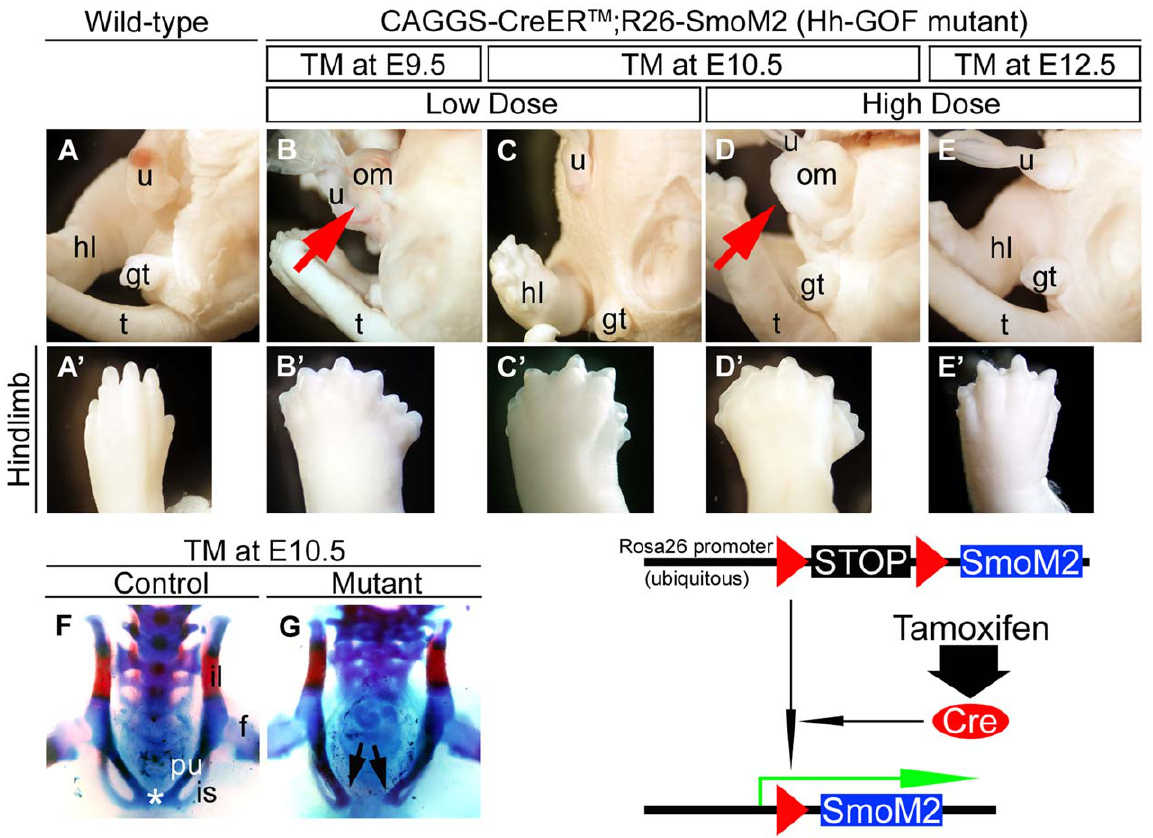
Figure 5. The conditional activation of Hh signaling by the protocols inducing omphalocele and pubic diastasis phenotypes. The R26-SmoM2 allele contains the constitutively activated form of Smoothened and a floxed stop cassette under the control of the Rosa26 promoter. By crossing R26-SmoM2 mice and the TM-inducible form of Cre-driver mice, administration of TM to the pregnant mice induced embryonic stage-specific gene recombination, allowing continuous activation of Hh signaling. The lateral view of the body trunk and the left hind limb of a wild-type embryo treated with a high dose of TM at E10.5 ( A , A’ ). Mutant embryos treated with a low dose of TM at E9.5 ( B , B’ ), a low dose of TM at E10.5 ( C , C’ ), a high dose of TM at E10.5 ( D , D’ ) and a high dose of TM at E12.5 ( E , E ’). Embryos were collected at E17.5 ( A–G and A’–E’ ). Mutant embryos treated with the low dose of TM at E9.5 and the high dose of TM at E10.5 showed omphalocele phenotypes ( B, D ; red arrows). Under such conditions, mutants displayed polydactyly phenotypes ( B’–E’ ). Control embryos at E17.5 developed a pubic symphysis ( F ; asterisk). Mutant embryos treated with a high dose of TM at E10.5 showed a pubic diastasis phenotype ( G ). Black arrows indicate the unclosed pelvis. f: femur, gt: genital tubercle, hl: hind limb, il: iliac bone, is: ischial bone, om: omphalocele, pu: pubic bone, t: tail, u: umbilical